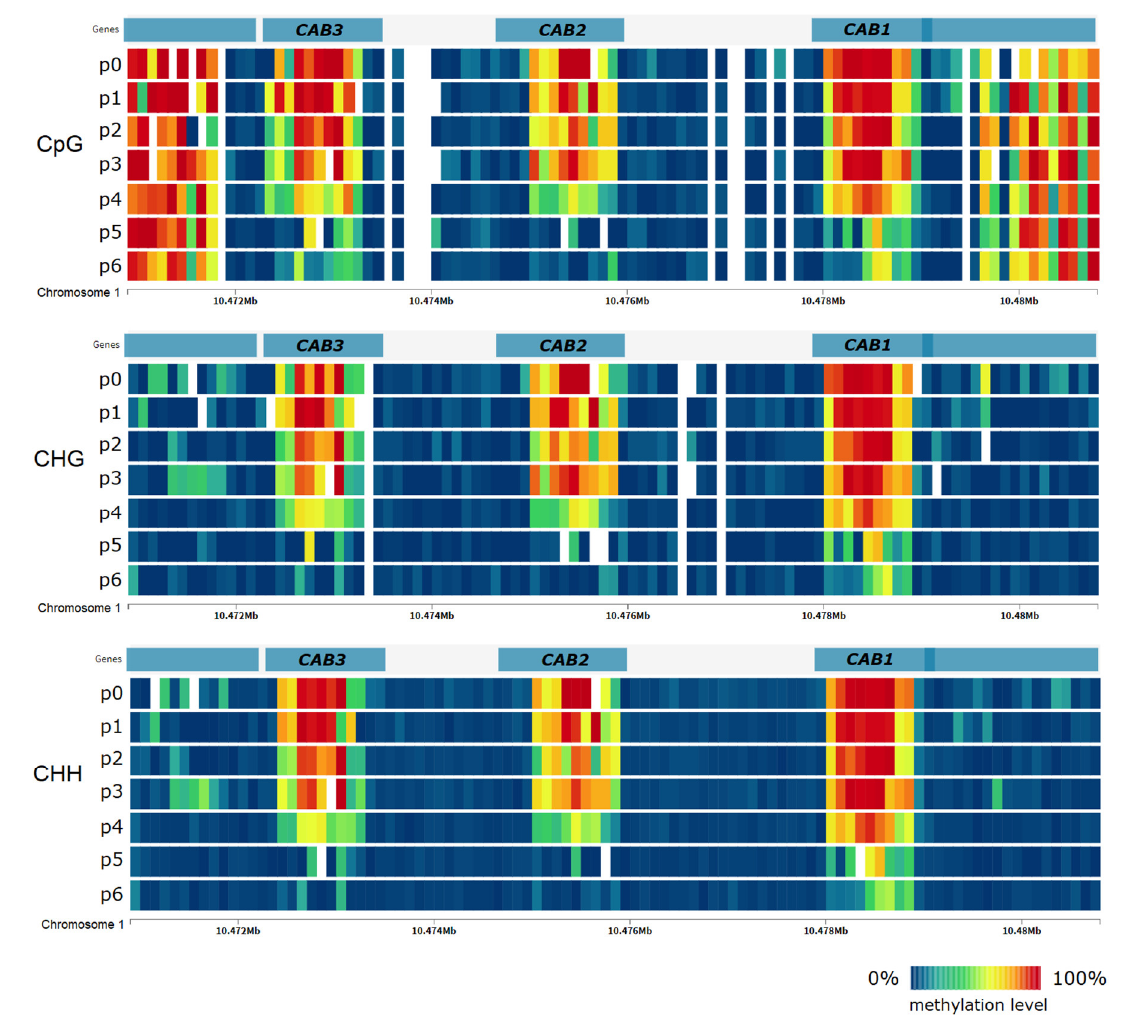
Figure 5. DNA methylation level in Arabidopsis thaliana genes encoding chlorophyll a-b binding proteins (CAB1, CAB2, CAB3) under heat stress in the subsequent time points of the experiment. DNA methylation level does not change significantly during heat stress (p1–p3) but decreases after transfer to normal conditions (p4–p6).